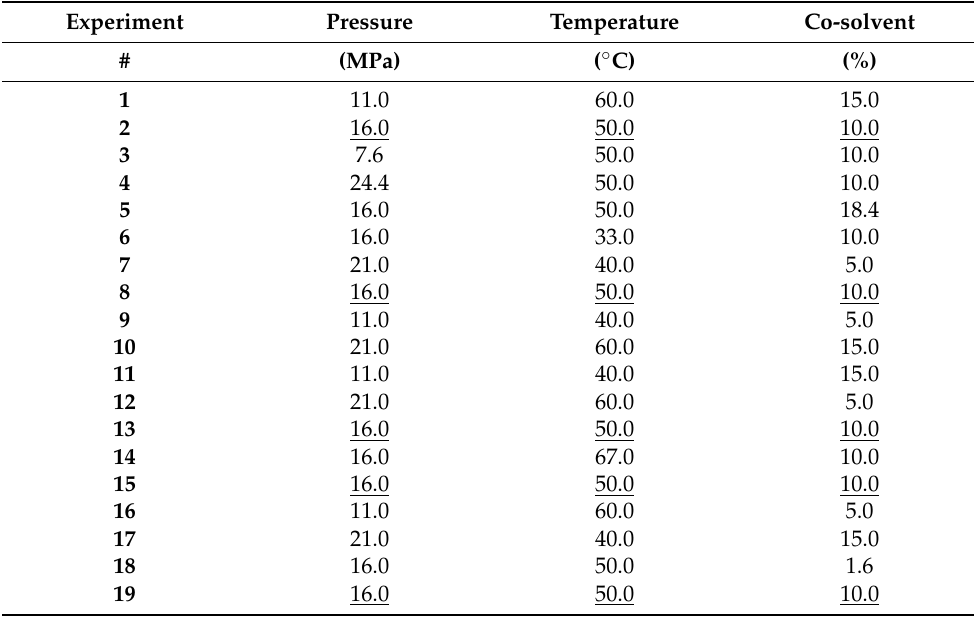
Table 1. Central composite experimental design for the preparation of extracts from mango seed kernel employing supercritical fluid extraction (CO 2 -EtOH).